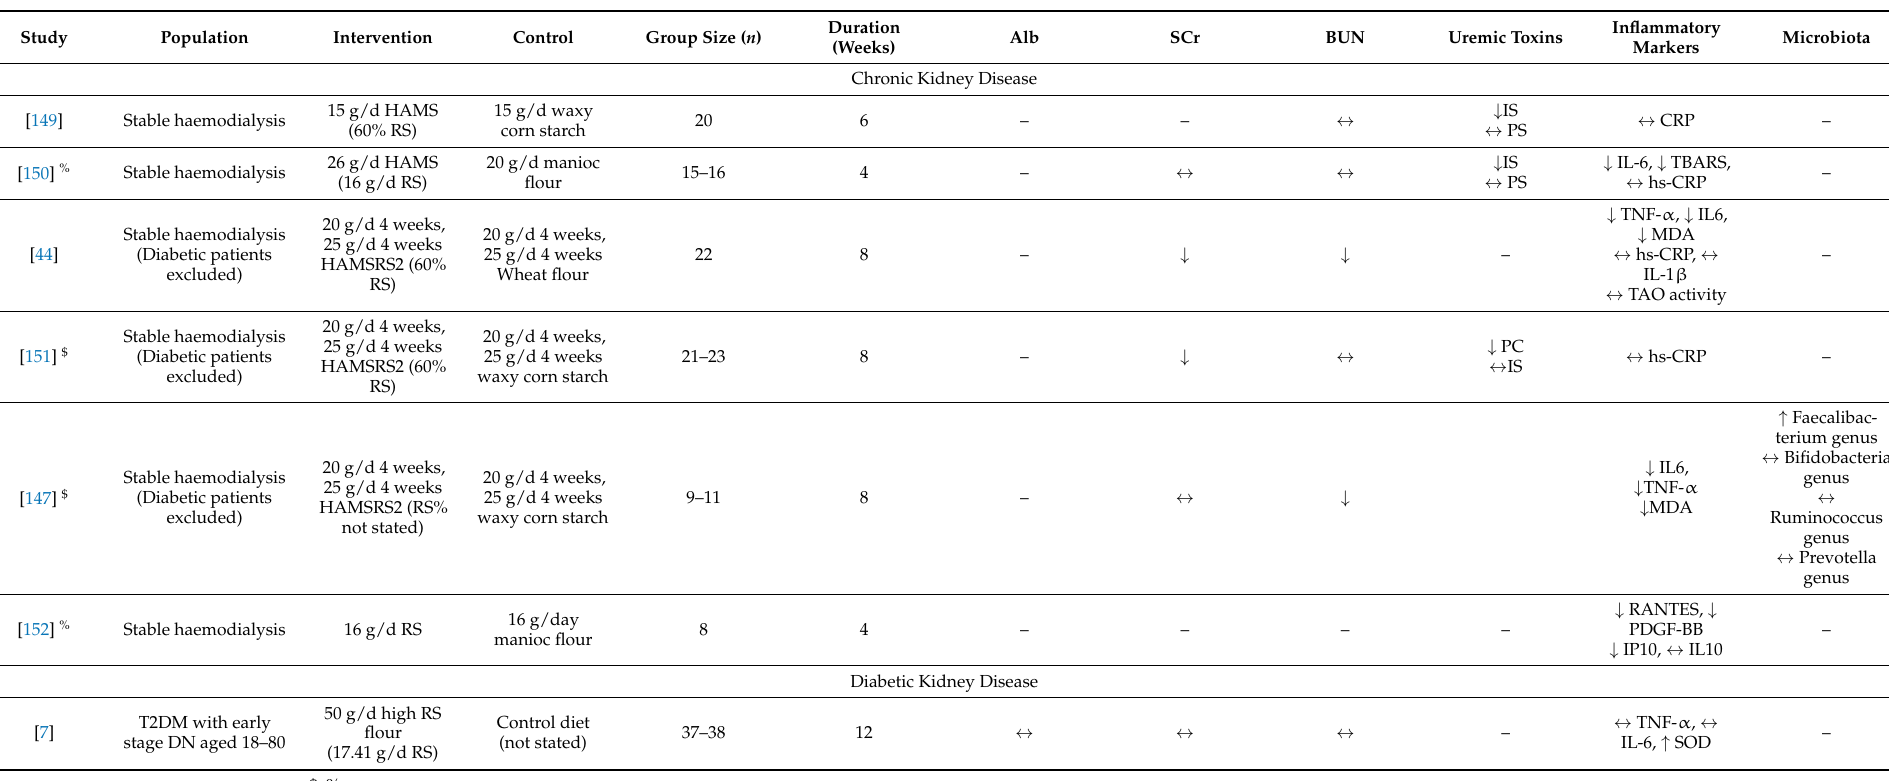
Table 3. Overview of Studies Investigating Resistant Starch in Humans With Chronic Kidney Disease And Diabetic Kidney